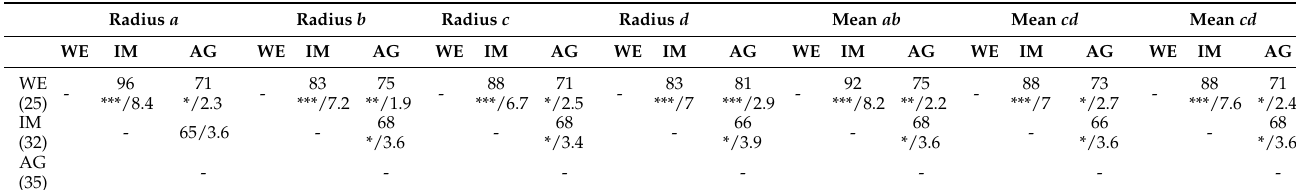
Table 3. Percentage of sign agreement ( Glk ), statistical significance and t BP -scores (given after) calculated among ring-width series of single radii (radius a , b , c , d ), mean values of combinations of radii ( a and b = ab; c and d = cd ) and all radii (= abcd ) among stocks sampled at a wind-exposed ridge (site WE), an intermediate site (IM) and a north-facing avalanche gully (site AG). Length of time series are given in brackets. * = p ≤ 0.05; ** = p ≤ 0.01; *** = p ≤ 0.001.